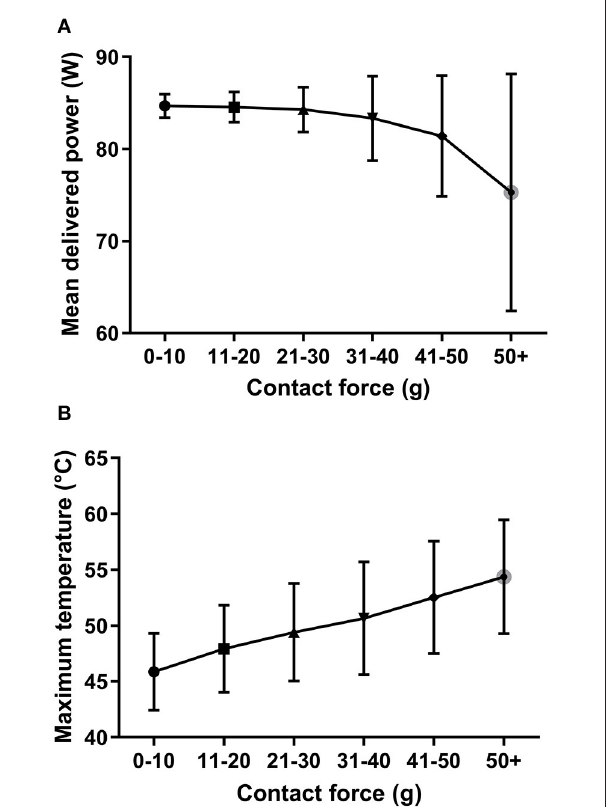
FIGURE 6 | (A,B) The association of the mean delivered power and maximum temperature to the different contact force ranges. Increasing contact force values result in higher temperatures but a lower delivered energy. This is the consequence of the appropriate regulation of the ablation generator. Median and interquartile